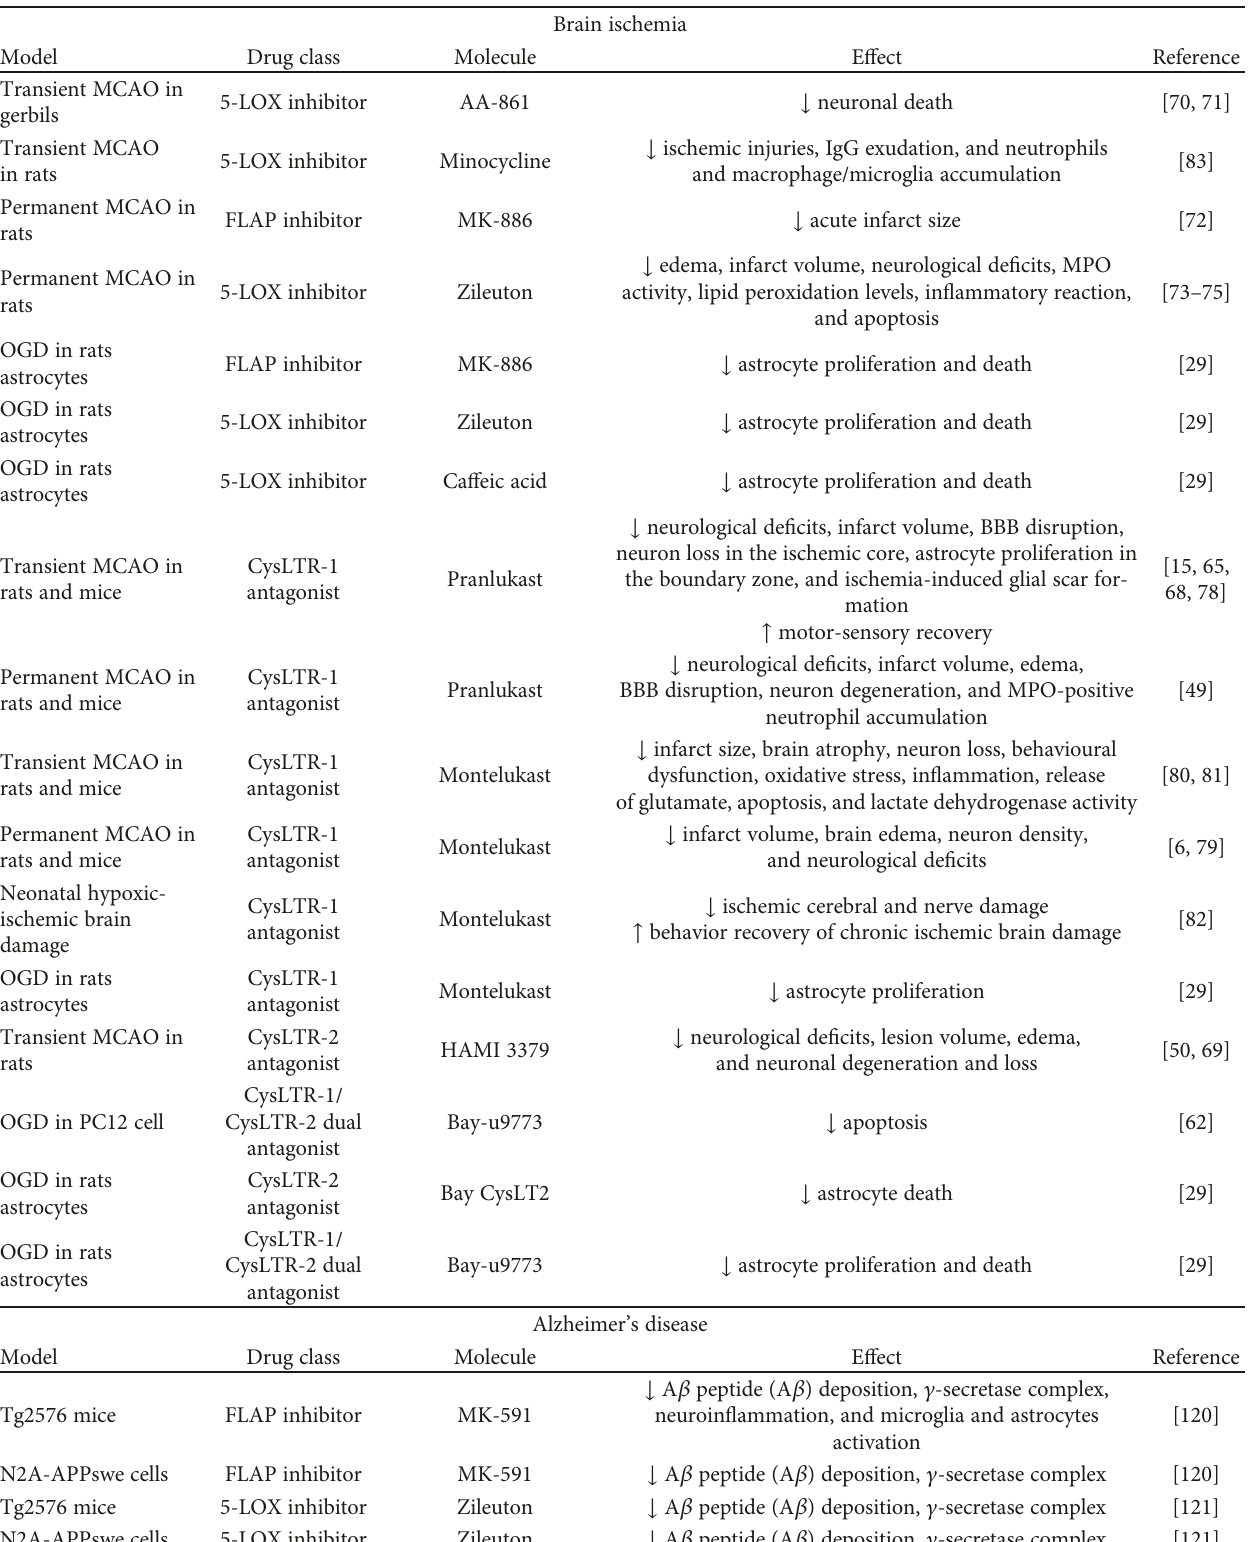
Table 1: The neuroprotective e ff ects of drugs acting on CysLT pathway in CNS